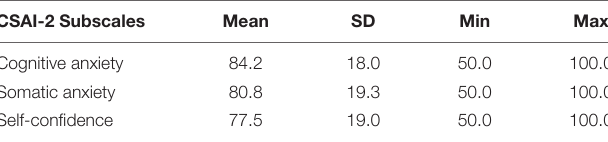
TABLE 2 | Average correct classification (in percentage) of outstanding performances* inside IZOF and less-than outstanding performances outside IZOF with the CSAI-2